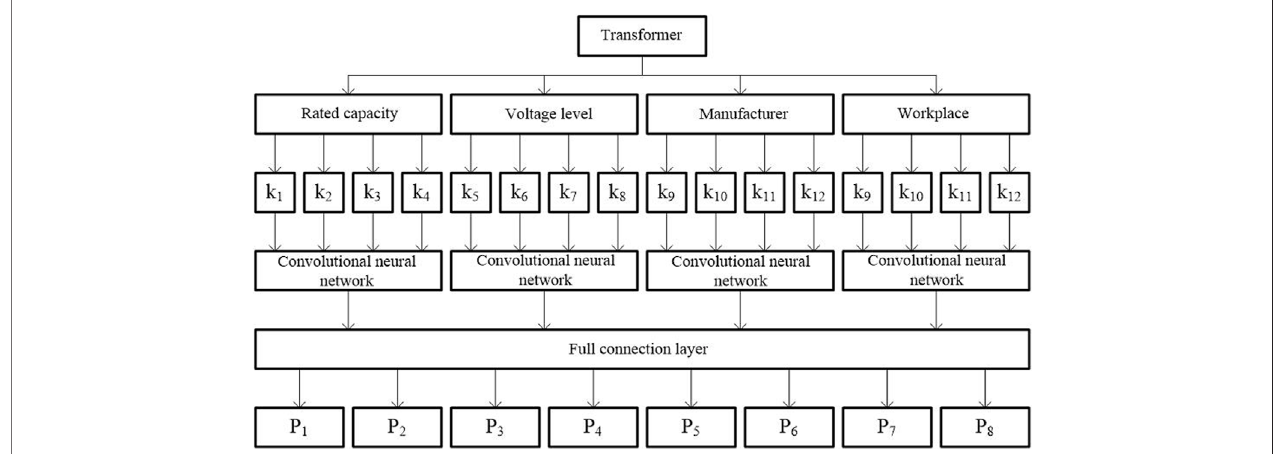
FIGURE 3 | Life prediction model.